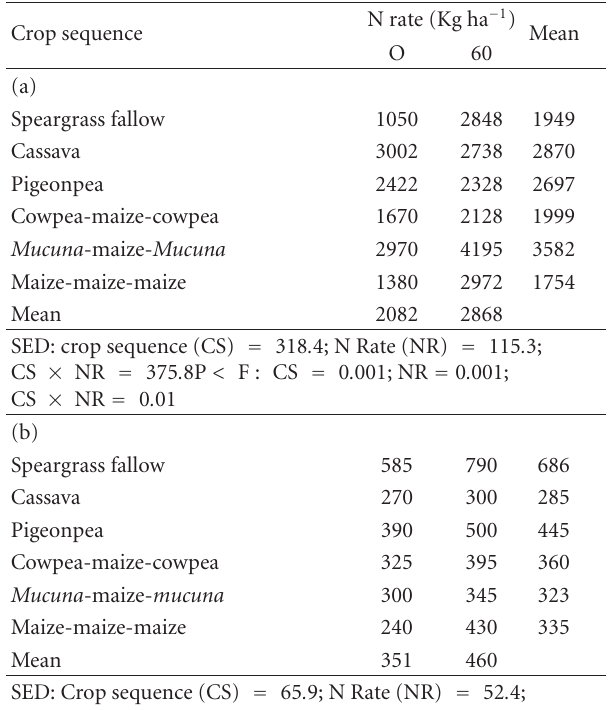
Table 3: E ff ect of crop sequence and N rate on (a) maize grain and (b) weed biomass associated with the maize crop at 8 weeks after planting on researcher-managed